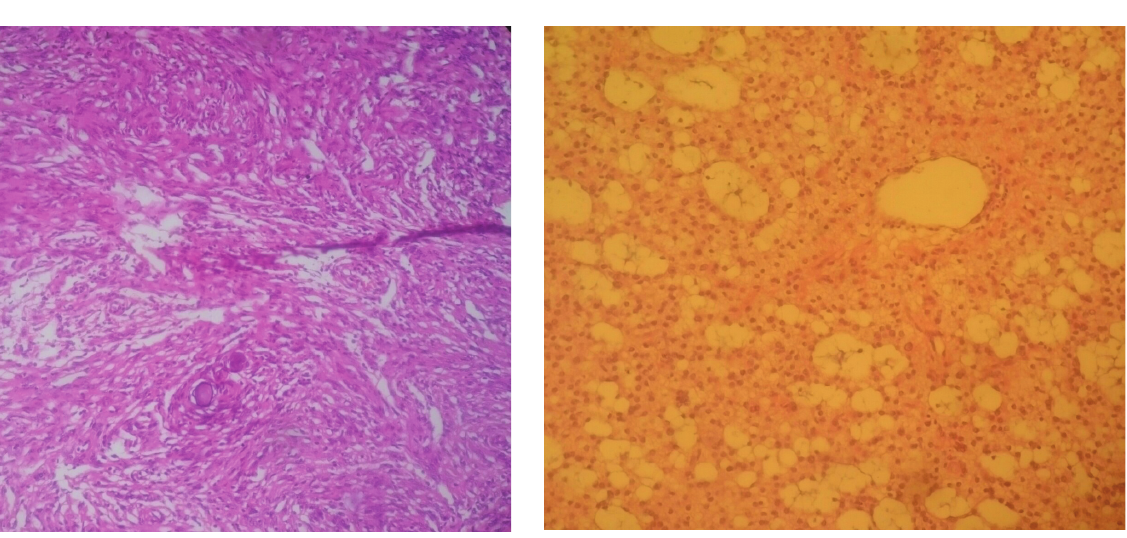
Figure 3B: Tissue Section: Oligoastrocytoma showing diffuse proliferation of tumor cells in fibrillary background showing moderate pleomorphism.